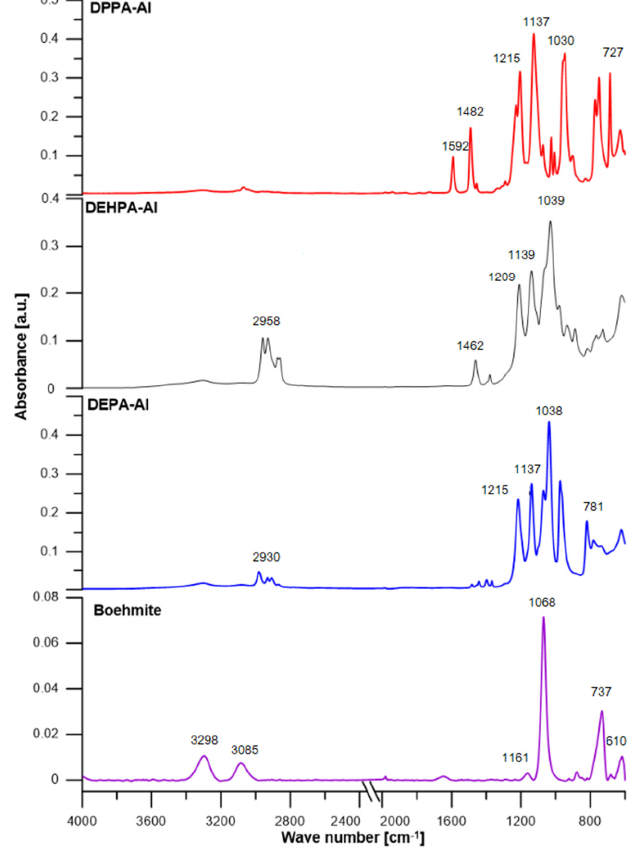
Figure 4. ATR-FT/IR spectra of boehmite and hybrids [cm −1 ]. Materials 2023 , 16 , 426